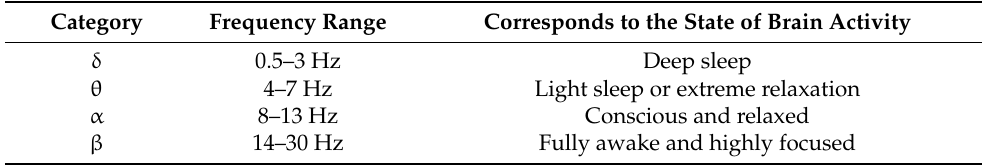
Table 2. EEG frequency allocation and functional activities.